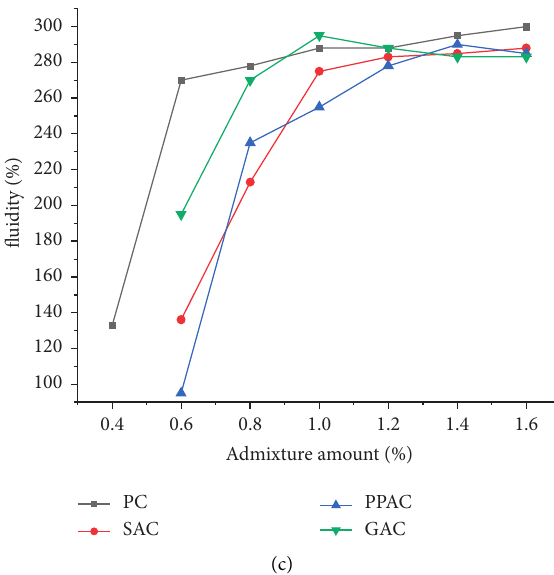
Figure 8: The fluidity change curve of four kinds of cementitious materials with the increase of admixtures. (a) Initial fluidity curve; (b) curve of 30-second fluidity; (c) curve of 60-second